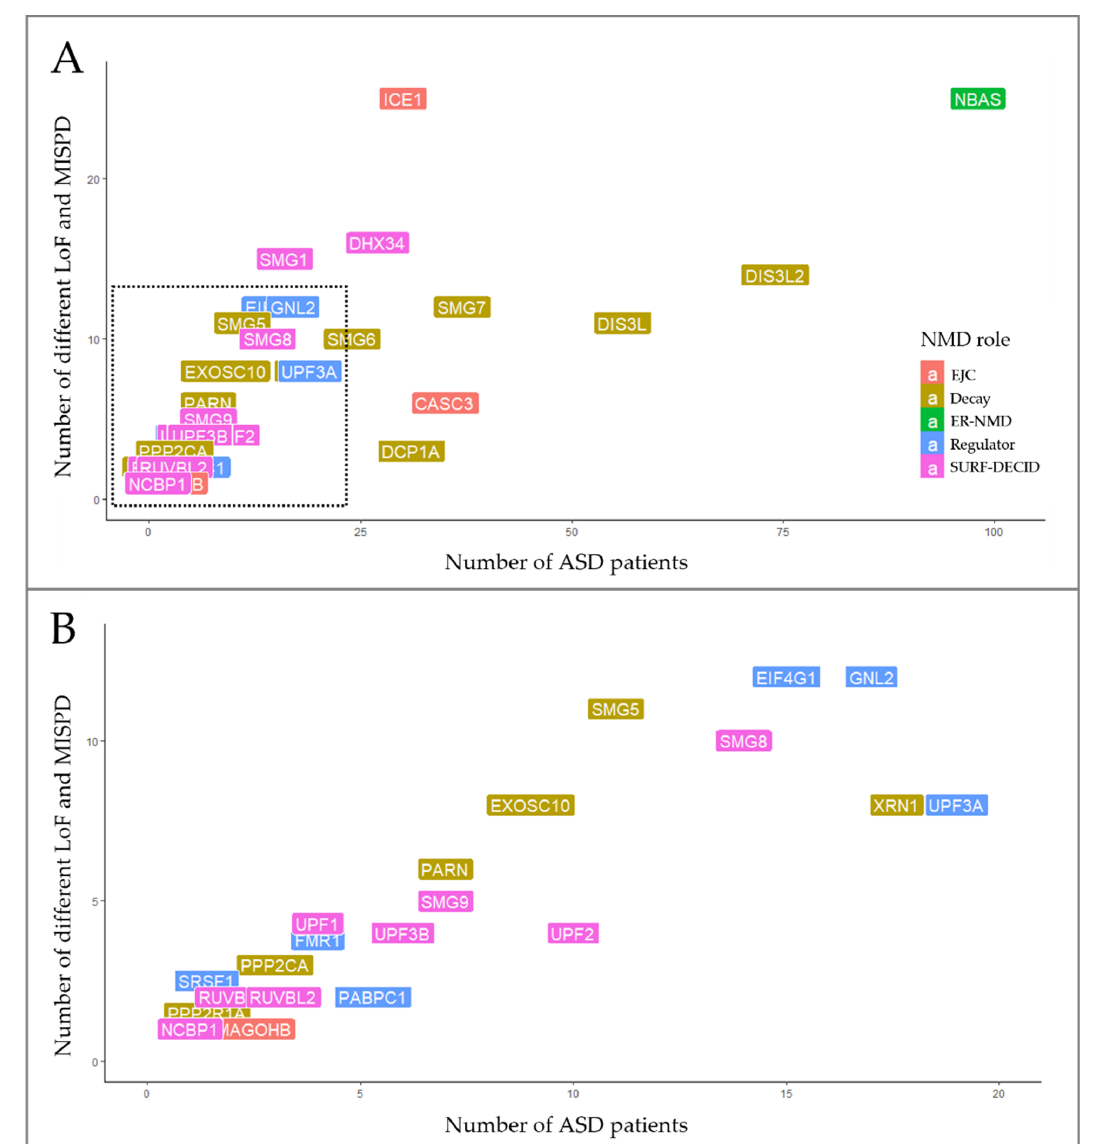
Figure 3. Distribution of rare SNVs predicted to be damaging among 38 NMD genes in ASD patients. ( A ) Variants in NMD genes were identified in 1 to 5% of ASD patients. ( B ) Detailed distribution of gene variants in <1% of the ASD population sample.